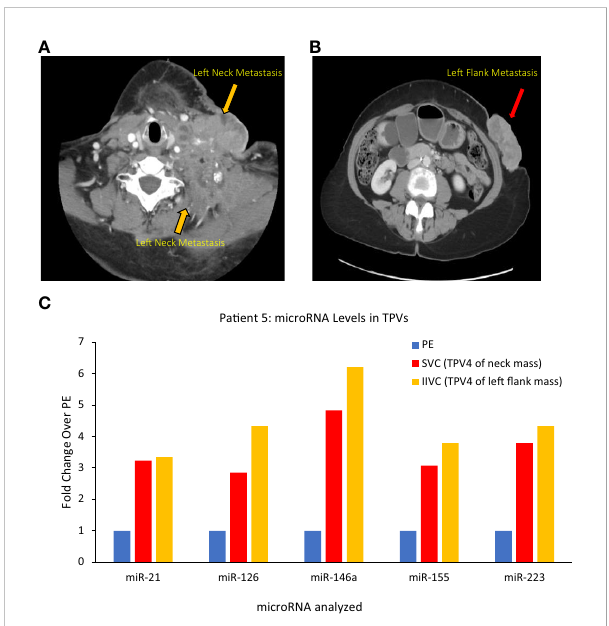
FIGURE 8 Images of Patient 5 ’ s left neck mass (A) , left fl ank/abdominal wall mass (B) , and microRNA analysis of tumor proximal vein (TPV) samples (C) . Higher levels of miR-21, miR-126, miR-146a, miR-155 and miR-223 were present in the superior vena cava (SVC, in yellow) and infrarenal inferior vena cava (IIVC, in red) that drain downstream from the neck mass and the left abdominal wall mass, respectively, compared to a peripheral sample from the left hand (PE) (all 2500P fraction). Of note, the SVC and the IIVC are downstream of the neck and abdominal wall masses, respectively, and can be considered TPV4 (not the immediate TDVs) for these masses. In spite of a dilution in tumor-associated miRNA levels expected in these samples, they were still higher than peripheral levels.